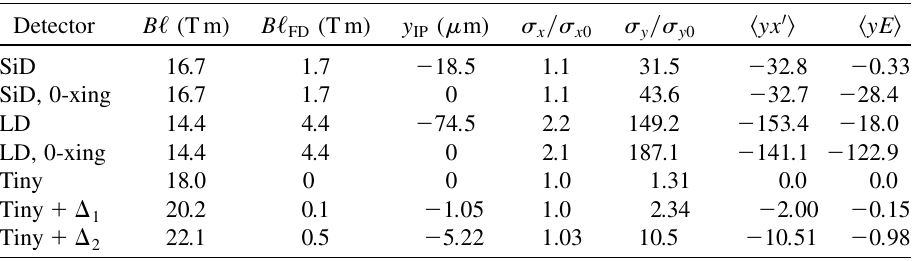
TABLE I. Uncompensated solenoid effects on the 250 GeV beam for different NLC detector models. Here B‘ is the full field integral over half the detector, and B‘ final doublet, i.e., for z > 3 : 51 m . The correlation terms h yx 0 i and h yE i are normalized to the nominal rms beam sizes.